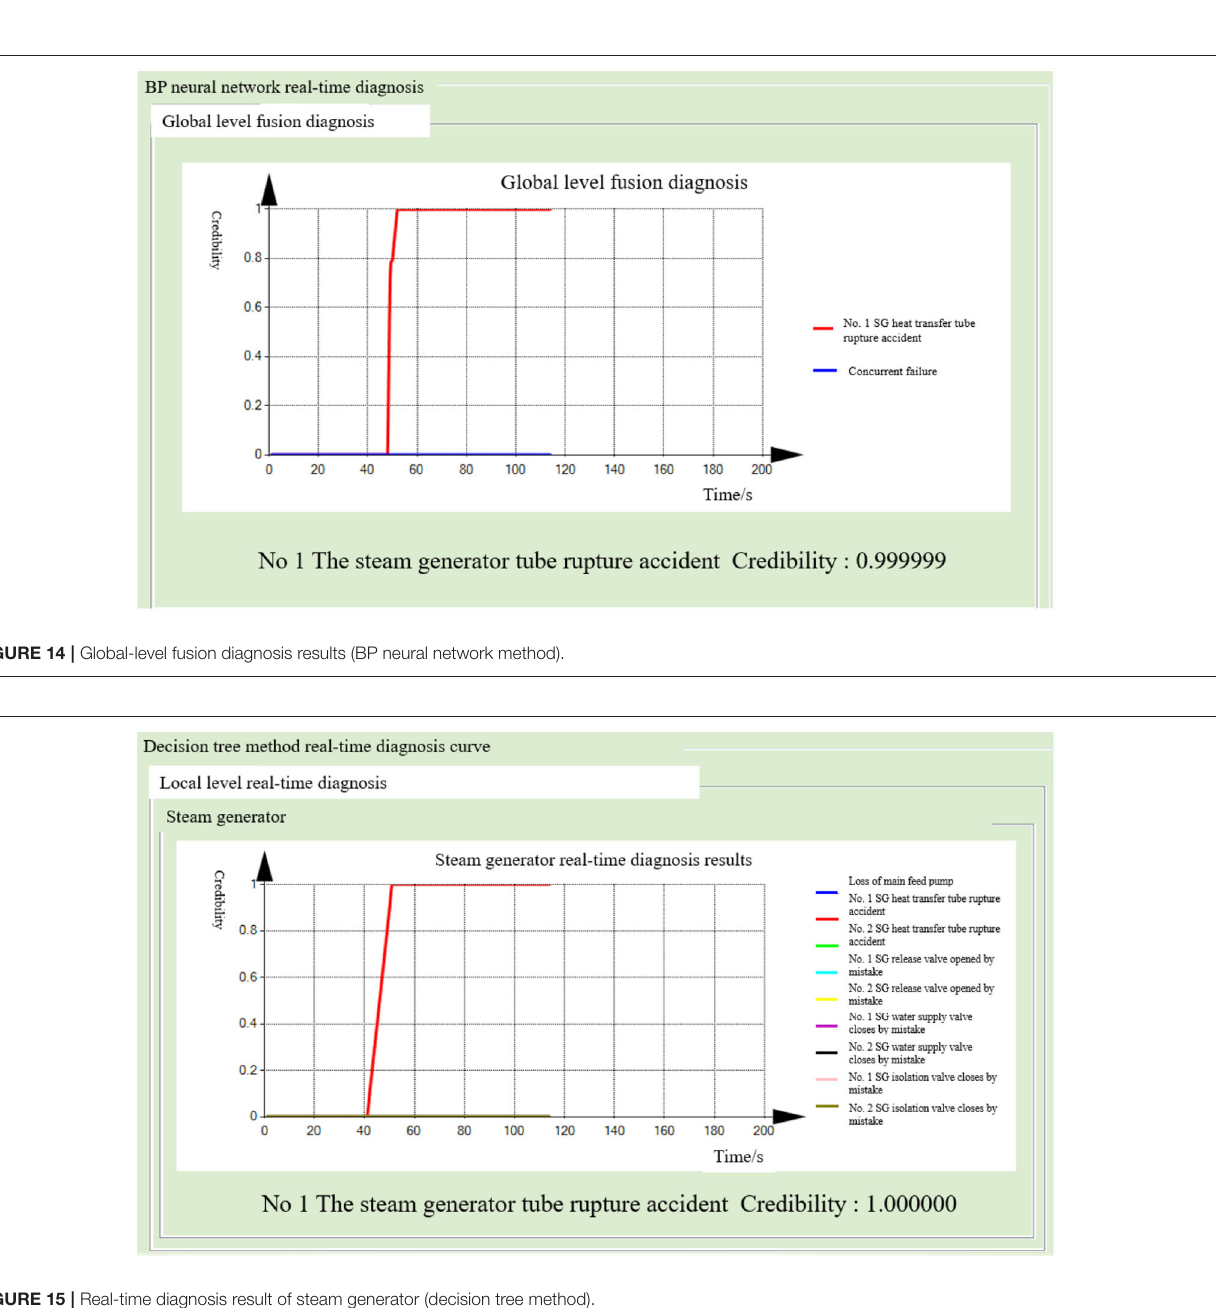
FIGURE 15 | Real-time diagnosis result of steam generator (decision tree